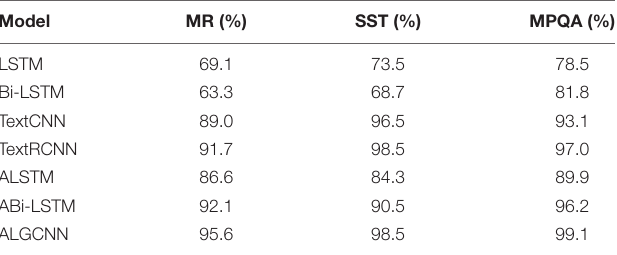
TABLE 1 | Text classification accuracy of different models on different data